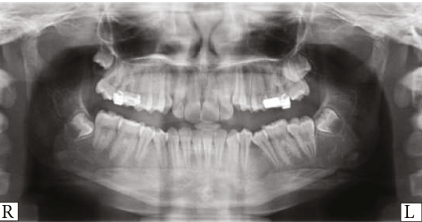
Figure 6: Orthopantomogram (OPG) showing the absence of any radiolucent lesion and the successful eruption of the mandibular left second